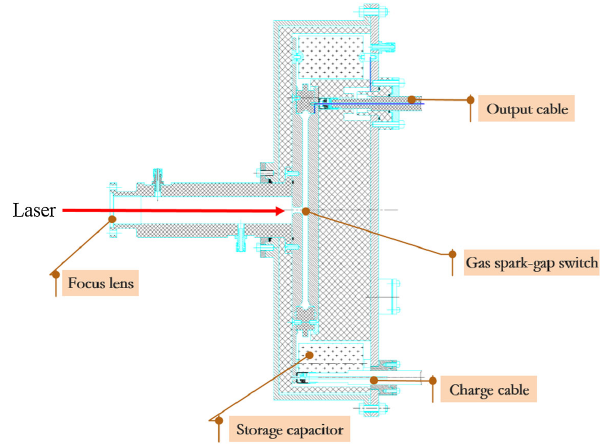
FIG. 16. Practical pictures of the whole trigger system (left: former-trigger unit; right: latter-trigger